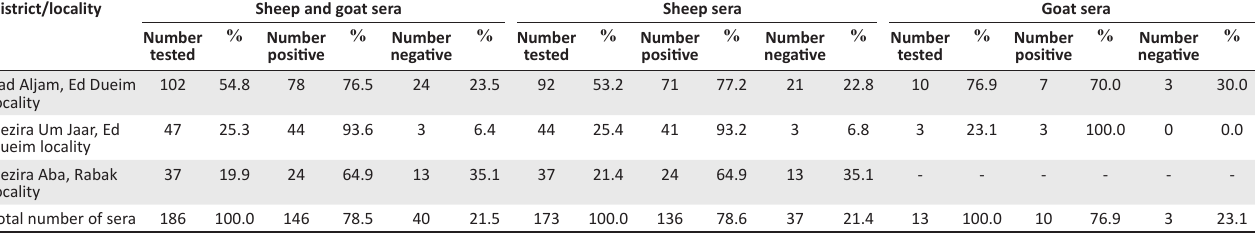
TABLE 5: Seroprevalence of peste des petits ruminants virus antibodies in sheep and goat sera within districts and localities of the White Nile State. District/locality